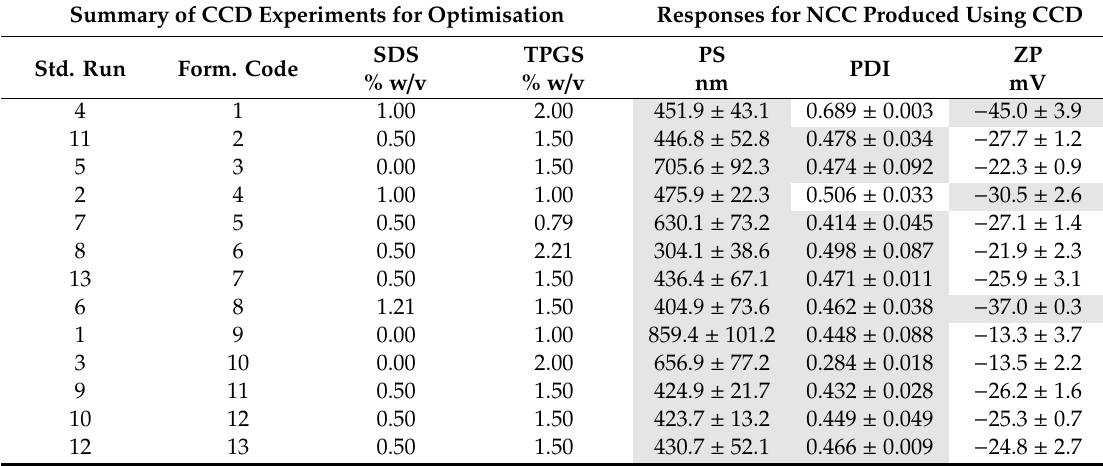
Table 3. Summary of variables used and responses for NCC produced using CCD.